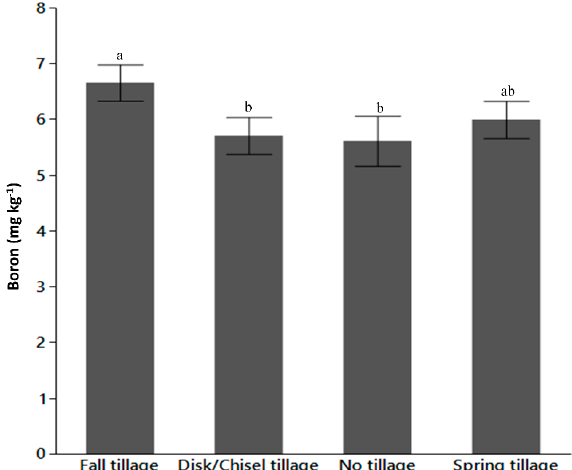
Figure 3. The long-term effect of tillage on the boron concentration in wheat straw under winter wheat–dry pea rotation. Bars sharing the same letter are not significantly different at 5% probability level. Error bars represent standard error of the least square mean.